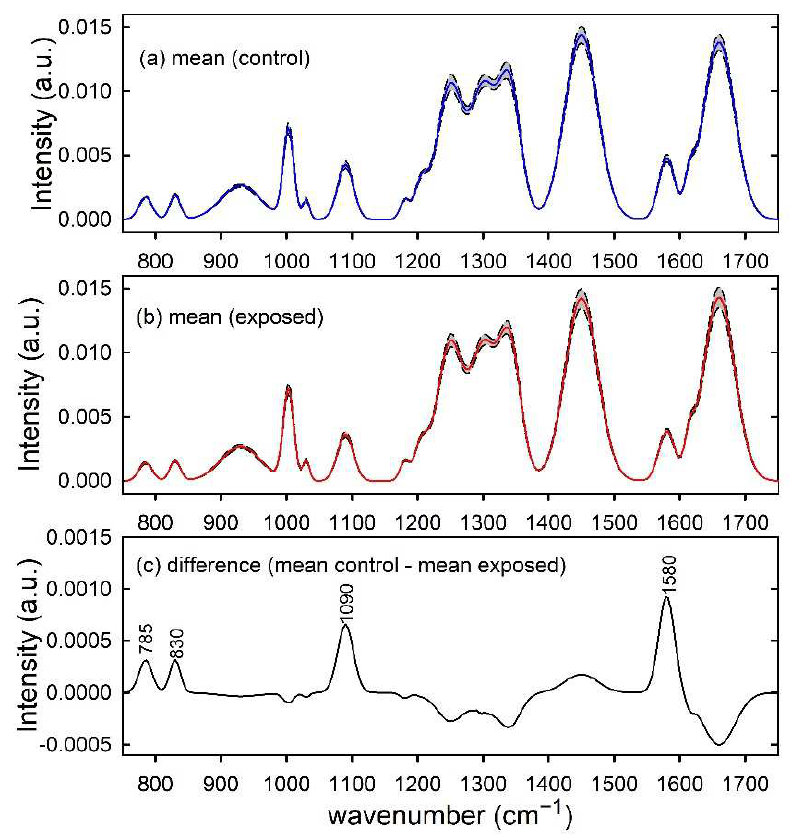
Figure 1. Synthetic spectra modelling control ( a ) and exposed ( b ) samples. The mean spectra are reported by blue and red lines in ( a , b ), respectively. Standard deviation spectra are also reported as dashed lines and the grey area corresponds to spectral values between mean ± standard deviation values. The spectral differences between mean values are reported in ( c ) and the wavenumber values of spectral features mainly contributing to such a difference are labelled for clarity.